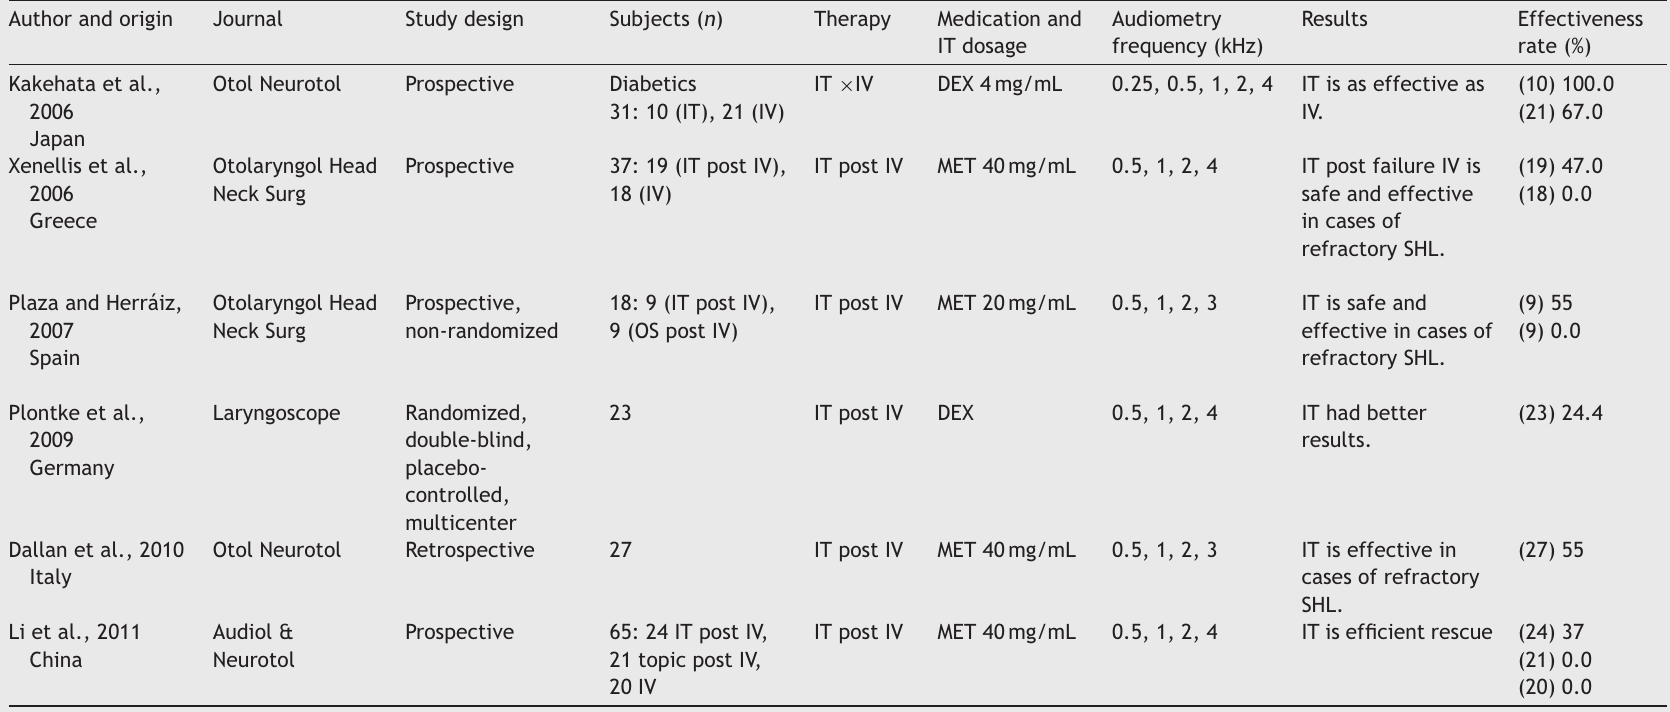
Studies emphasizing salvage therapy after failure of intravenous